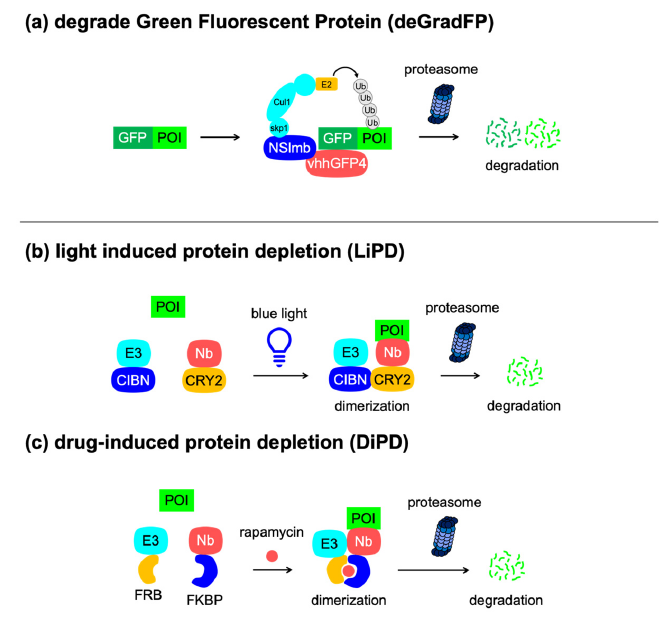
Figure 5. Nanobody ‐ based degrons. Concepts of ( a ) deGradFP, ( b ) LiPD, and ( c ) DiPD. Nanobody Nanobody-based degrons. Concepts of ( a ) deGradFP, ( b ) LiPD, and ( c ) DiPD. (Nb) Nanobody